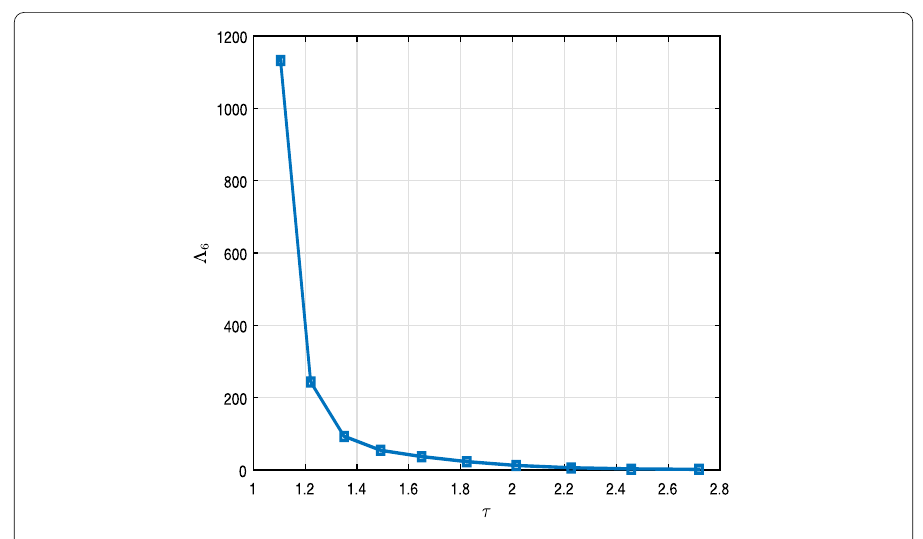
Figure 6 2D-graph of (cid:19) 6 for τ ∈ J in Example